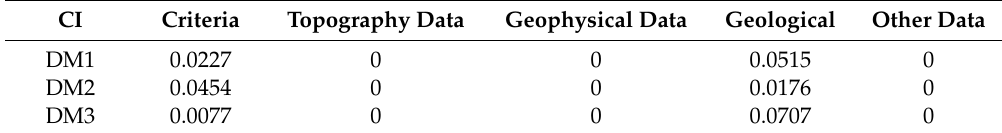
Table 4. Consistency ratio (CR) for pairwise comparison matrix.